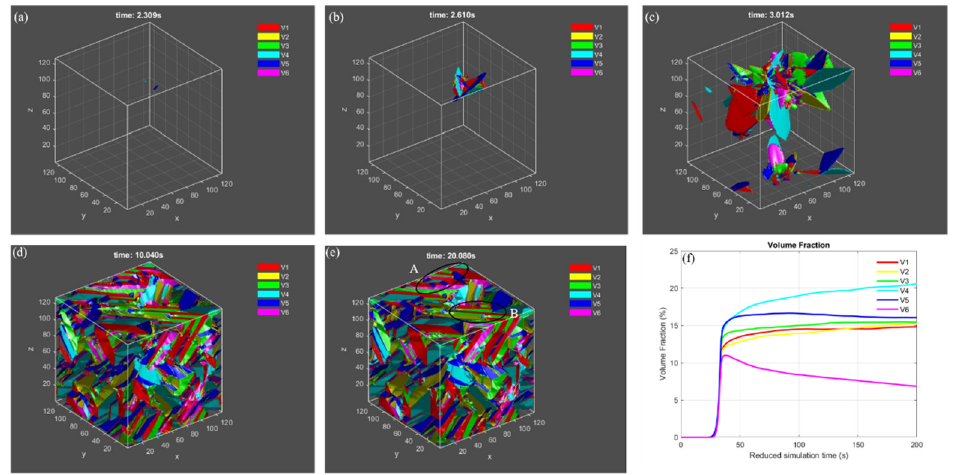
Figure 2. Microstructure evolution during martensitic transformation ( a – e ), and volume fraction of variants as a function of reduced simulation time ( f ).